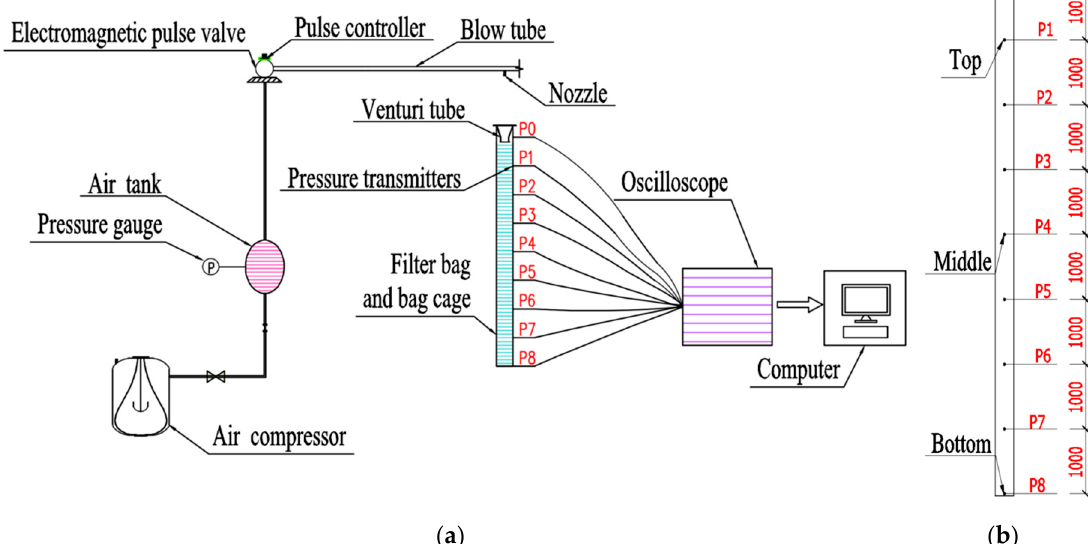
Figure 3. Experimental bench approach for determining the pulse jet cleaning performance. ( a ) Schematic diagram of the pulse jet cleaning experimental device and ( b ) the distribution of the measuring points on the filter bag. P0–P8 are the numbers of the measuring points.